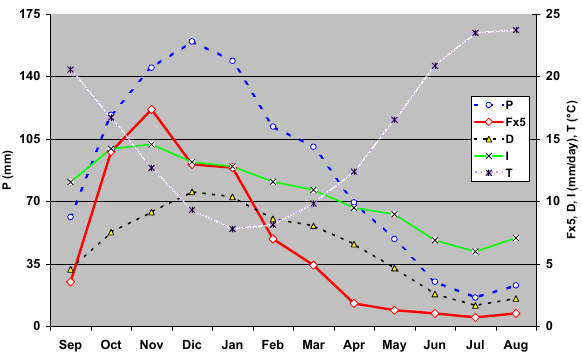
Fig. 5. Regime of precipitation ( P ), floods ( F ), wet days ( D ), pre- cipitation intensity ( I ), and temperature ( T